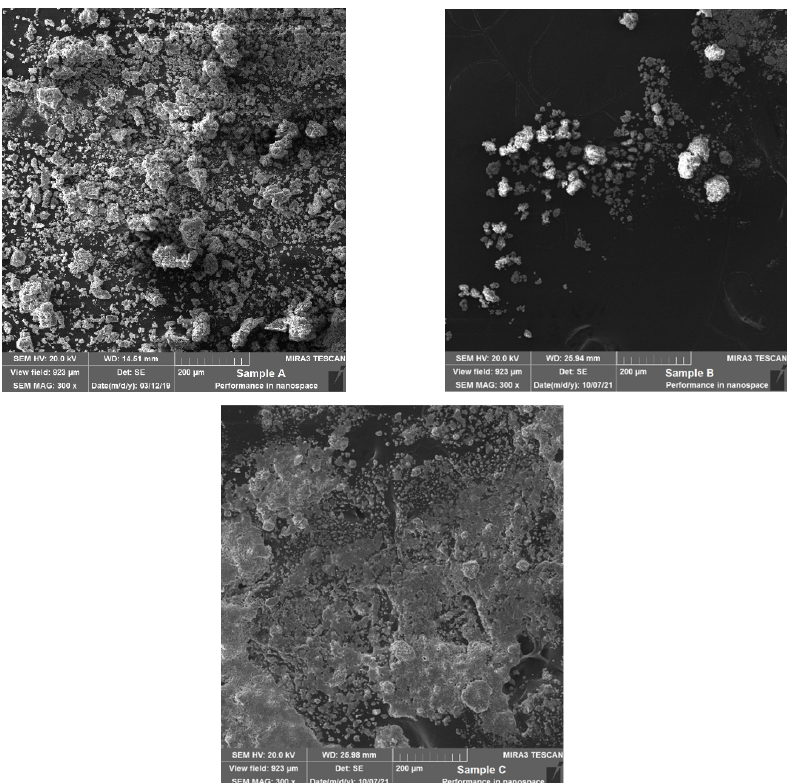
Figure 2. Particle morphology of zinc flue samples A, B, and C.